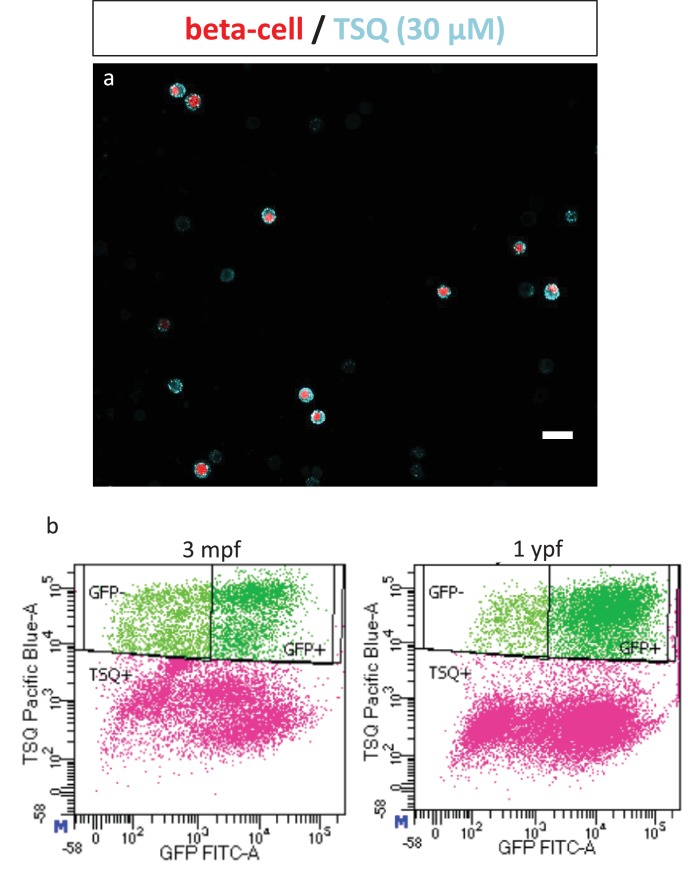
Fluorescent activated cell sorting of NF-kB:GFPhigh and NF-kB:GFPlow beta-cells.(a) Confocal image of dissociated cells from dissected islets of 3 mpf Tg(ins:nlsRenilla-mKO2) animals that were labeled with TSQ (Zn2+ labeling dye). Islets were incubated with TSQ after dissociation and imaged using a confocal microscope. Beta-cells show RFP expression (red) while cells rich in Zn2+ are labeled with TSQ (cyan). TSQ strongly labels all beta-cells and weakly labels some unknown endocrine cells. (b) Fluorescent activated cell sorting (FACS) of live TSQ-positive GFPhigh and GFPlow cells from Tg(NF-kB:GFP) animals at 3 mpf and 1 ypf. Dead cells were labelled using far-red stain DRAQ7.